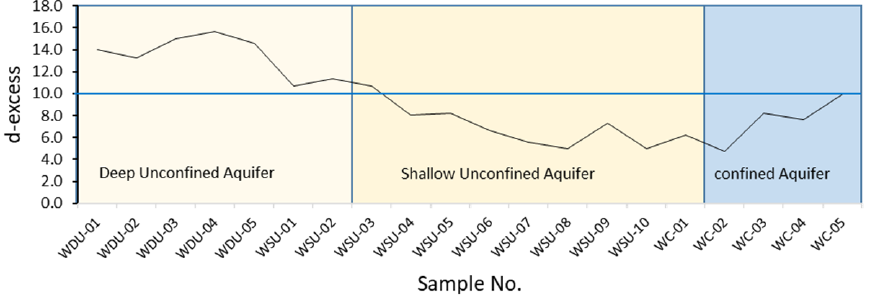
Figure 13. Values of d-excess of tested groundwater samples.